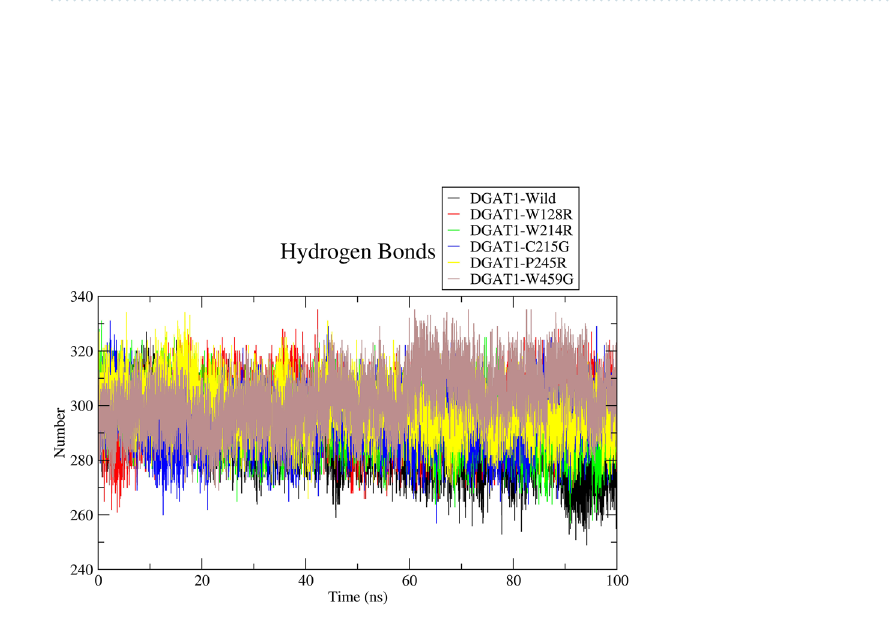
Figure 5. Conformational dynamic analysis of DGAT1-wild type and its variants using MD simulation. ( A ) RMSD, ( B ) RMSF, ( C ) Rg, and ( D ) SASA.